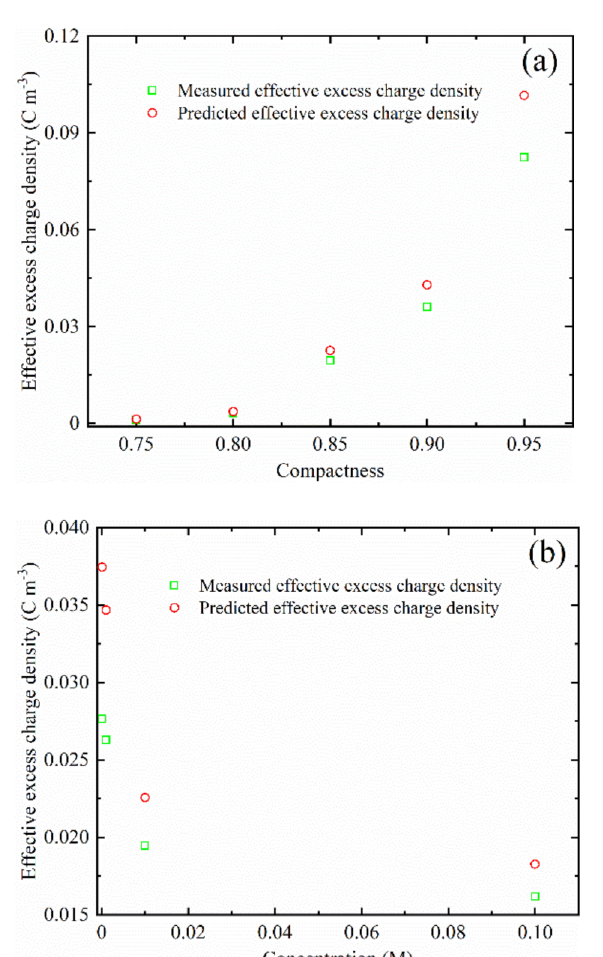
Figure 10. Comparing the measured the effective excess charge density with the predicted value by the model of Guarracino and Jougnot [32]. ( a ) The measured and predicted effective excess charge density with different compactness. ( b ) The measured and predicted effective excess charge density with different